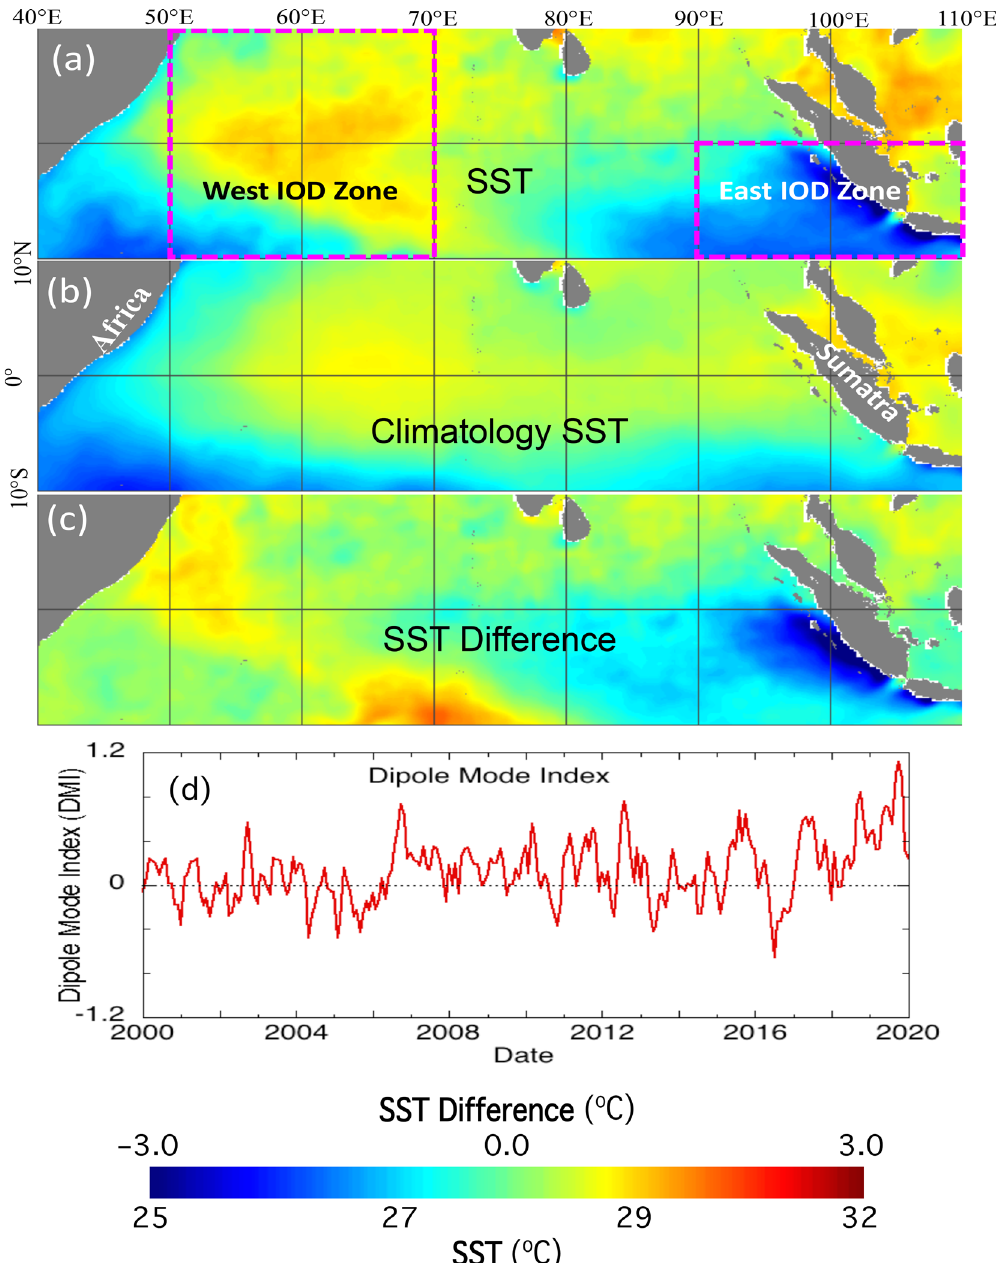
Figure 1. ( a ) SST in October 2019 in the equatorial Indian Ocean, ( b ) mean climatology SST in the equatorial Indian Ocean between 2012 and 2019, ( c ) SST difference between SST in October 2019 and the same-month climatology SST, ( d ) temporal variation of the DMI since 2000. Note that the west IOD zone (50°E ‒ 70°E, 10°S ‒ 10°N) and the east IOD zone (90°E ‒ 110°E, 10°S ‒ 0°N) are marked in Fig.